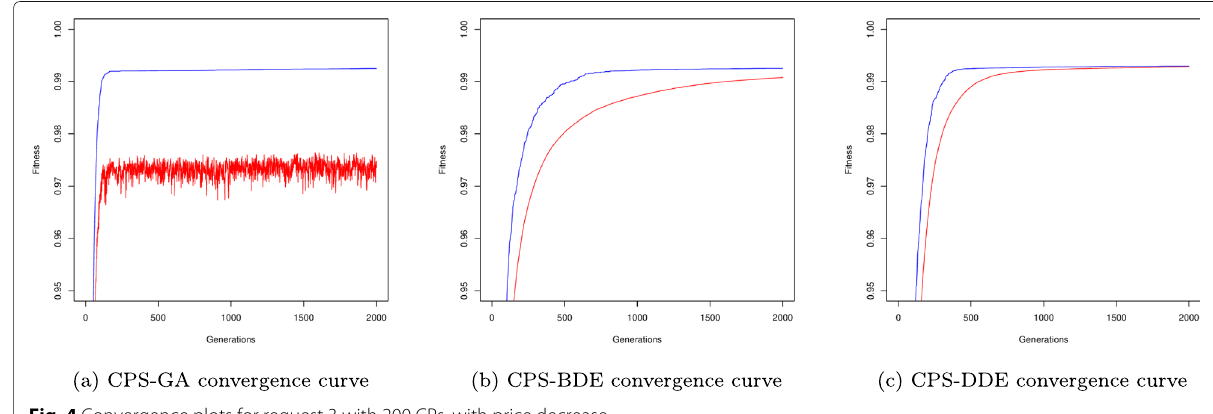
Fig. 4 Convergence plots for request 3 with 200 CPs, with price decrease